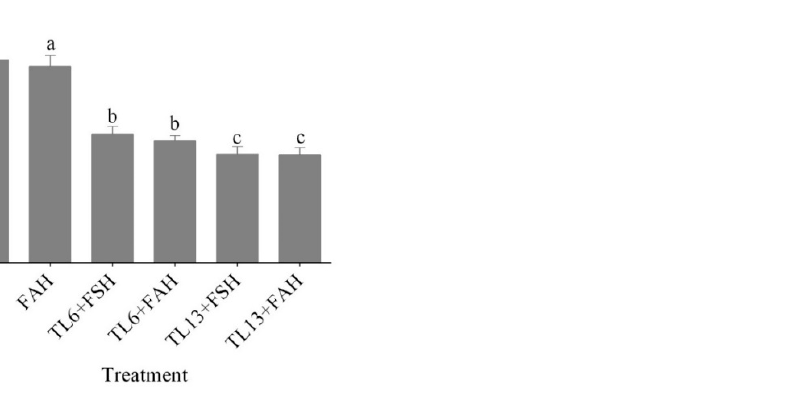
Figure 5. Effects of T. longibrachiatum on F. solani (FSH) and F. avenaceum (FAH) disease index in potted snow pea plants. Data are presented as mean ± standard errors (SE) of two independent experiments in three replicates. Means with the same lowercase letters are not significantly different at p < 0.05, according to Duncan’s multiple range tests.